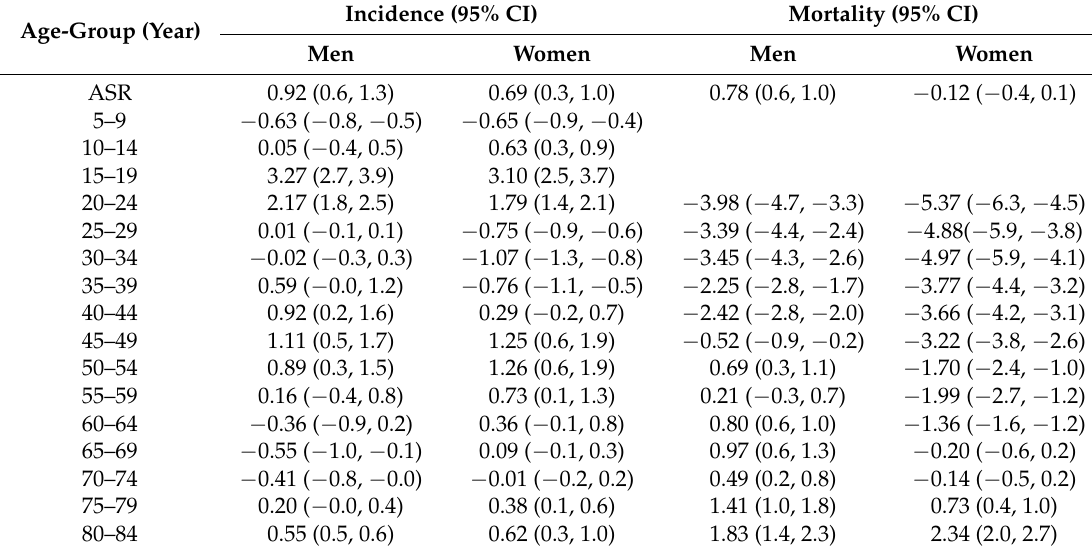
Table 1. The average annual percent changes (AAPC) in incidence and mortality of diabetes,